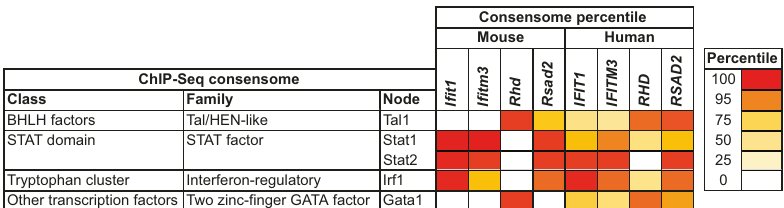
Fig. 6 Transcriptional regulatory relationships between cross-species AIWG-P genes and immunomodulatory transcription factors are highly conserved between mice and humans. Shown are percentile rankings of the four cross-species AIWG-P genes in human and mouse ChIP-Seq consensomes for which at least one of both the human and mouse orthologs is a HCT. Refer to the Supplementary fi le for the human AIWG-P and AIWG-R gene sets (section 6) and the full list of mouse and human percentile rankings for the four genes (section